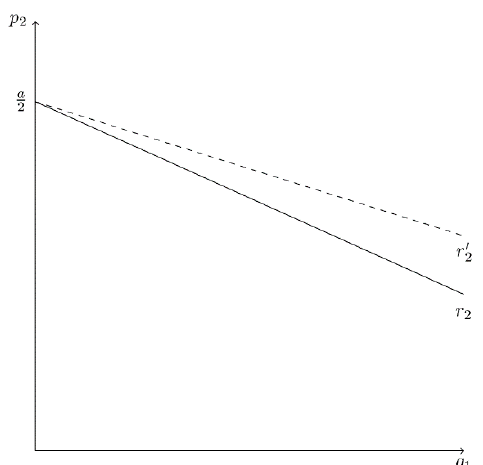
Figure 14. Firm 2’s Best-Reply Curve in the Cournot-Bertrand Model When CEO 2 Underestimates Product Substitutability.